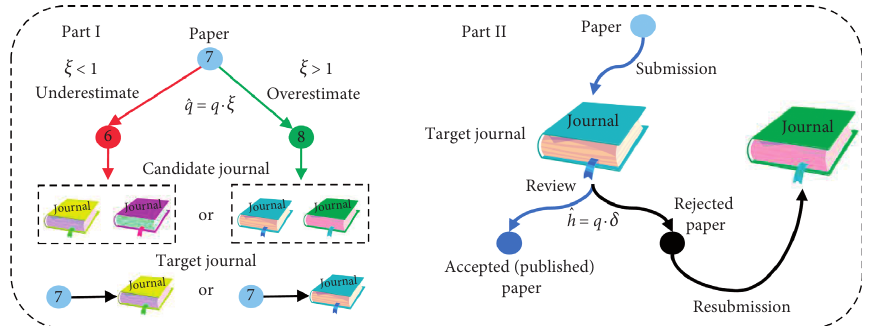
Figure 3: Summary of the submission process. In the example depicted, the author will select a target journal for submission based on the submission principles. Clearly, the target journal would be very different if the result of author’s estimation on the paper is different. In Part II, according to the scores and ranks of the paper, the paper will be accepted (published) or rejected by the journal, and the rejected paper will be resubmitted to other journals in the next